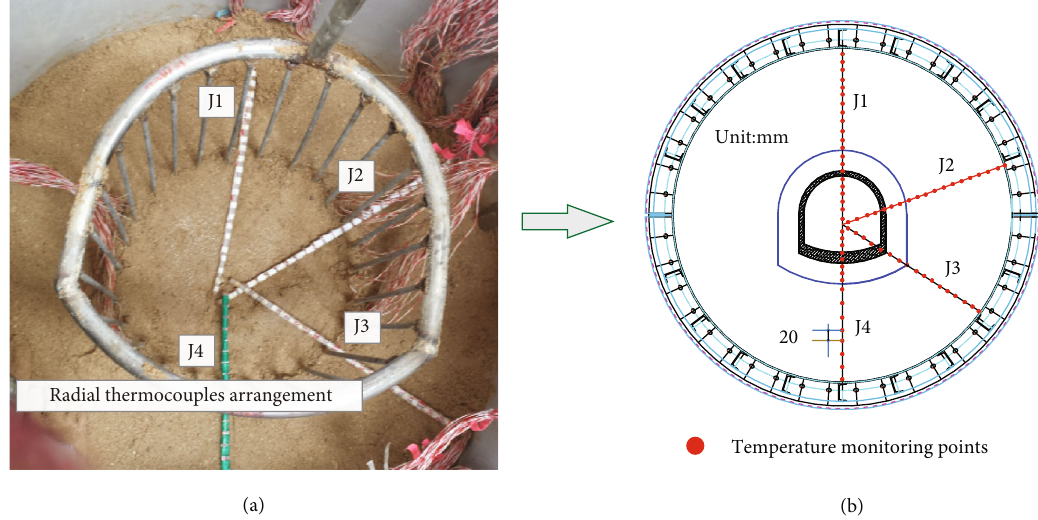
Figure 6: Radial temperature measurement arrangement: (a) Site photo and (b) Schematic diagram of speci fi c parameters.